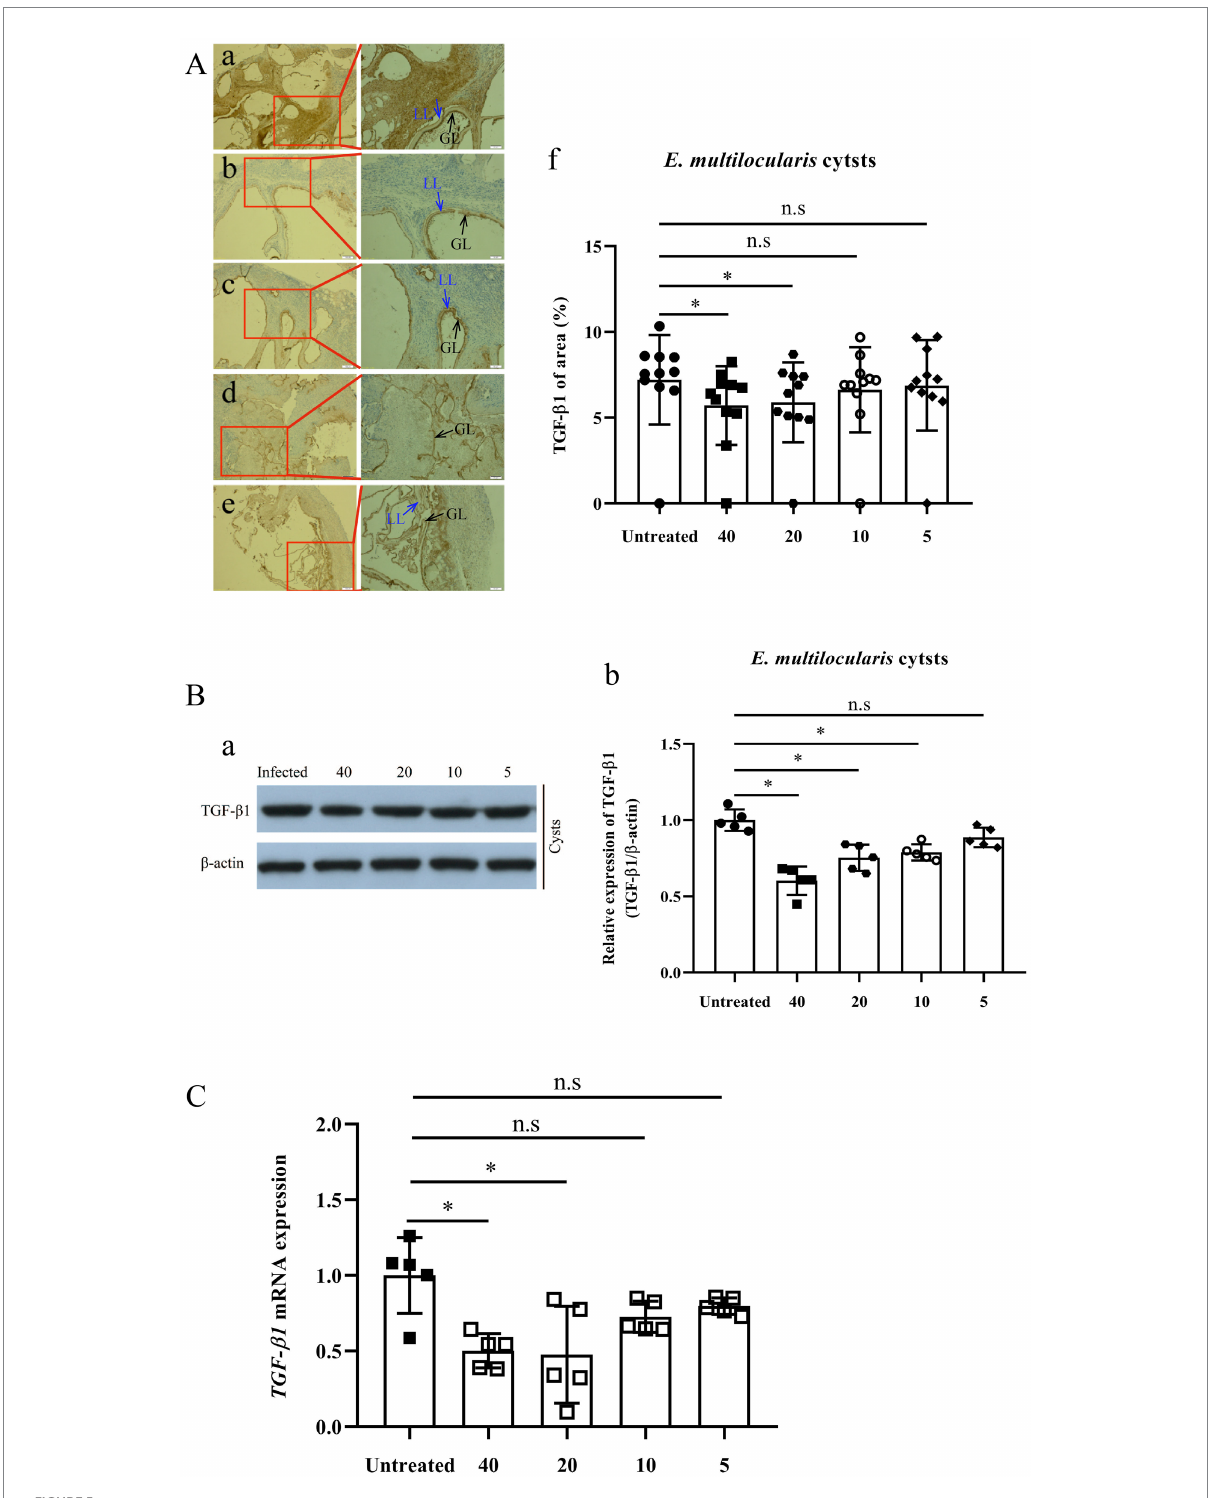
FIGURE 5 Expression of TGF- β 1 protein and mRNA in Echinococcus multilocularis cysts after treatment with PAB for 12 weeks, as measured by immunohistochemistry-paraffin (IHC-P), Western blot (WB) and real-time quantitative PCR (RT-qPCR) assay. (A) Images of TGF- β 1 protein expression in E. multilocularis cysts from the mice (a) untreated, and treated with PAB (b) 40, (c) 20, (d) 10, and (e) 5 mg/kg, as measured by IHC-P assay; and (f) semi-quantitative analysis of TGF- β 1 protein, as measured by ImageJ software. Brown area indicates expression of TGF- β 1 protein, Laminated layer (LL, blue arrow) and germinal layer (GL, black arrow) in E. multilocularis cysts. Magnification, × 100 and × 200. (B) WB analysis of (a) TGF- β 1 and β -actin expression in E. multilocularis cysts in the untreated, and treated with PAB of 40, 20, 10, and 5 mg/kg PAB mice, and (b) the semi-quantitative analysis of TGF- β 1 protein, as measured by ImageJ software. (C) Analysis of TGF- β 1 mRNA expression in E. multilocularis cysts by RT-qPCR. All data were assessed using One-way ANOVA with multiple comparisons. LL, laminated layer; GL, germinal